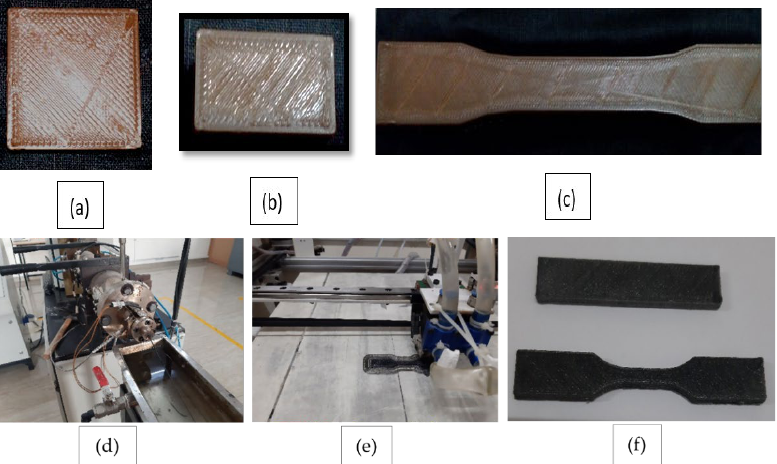
Figure 2. ( a – c ) show pure PETG 3D-printed samples based on the ASTM standards; ( d ) twin screw extrusion of the 3D printing of the PETG filament; ( e ) 3D printing of the PETG+MWCNT tensile specimen; ( f ) final printed PETG+MWCNT